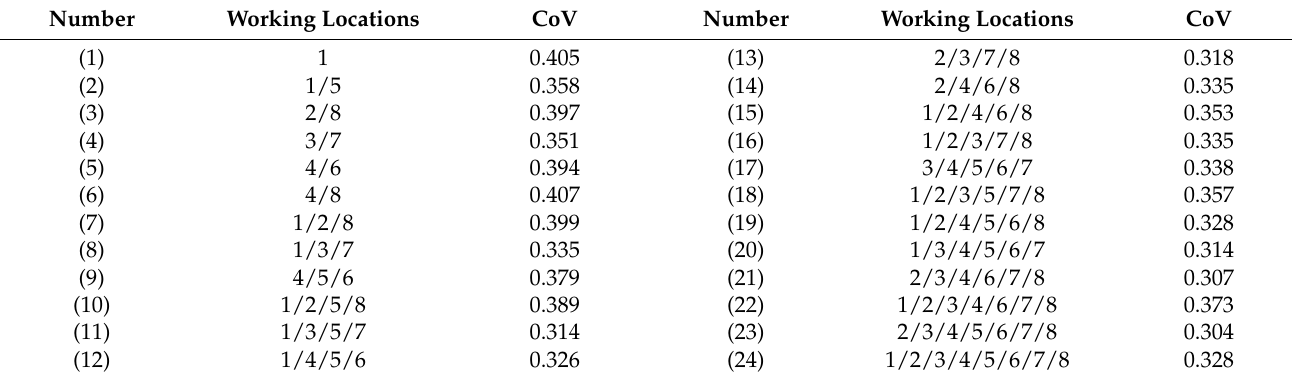
Table 2. Electric field distribution under different arrangement of microwave